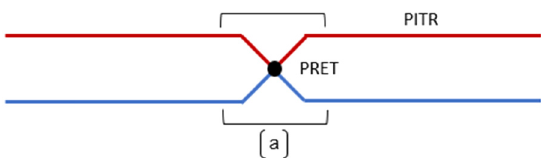
Figure 3: Upward movement of pret to become a pitr where ( a ) signi fi es liminality.